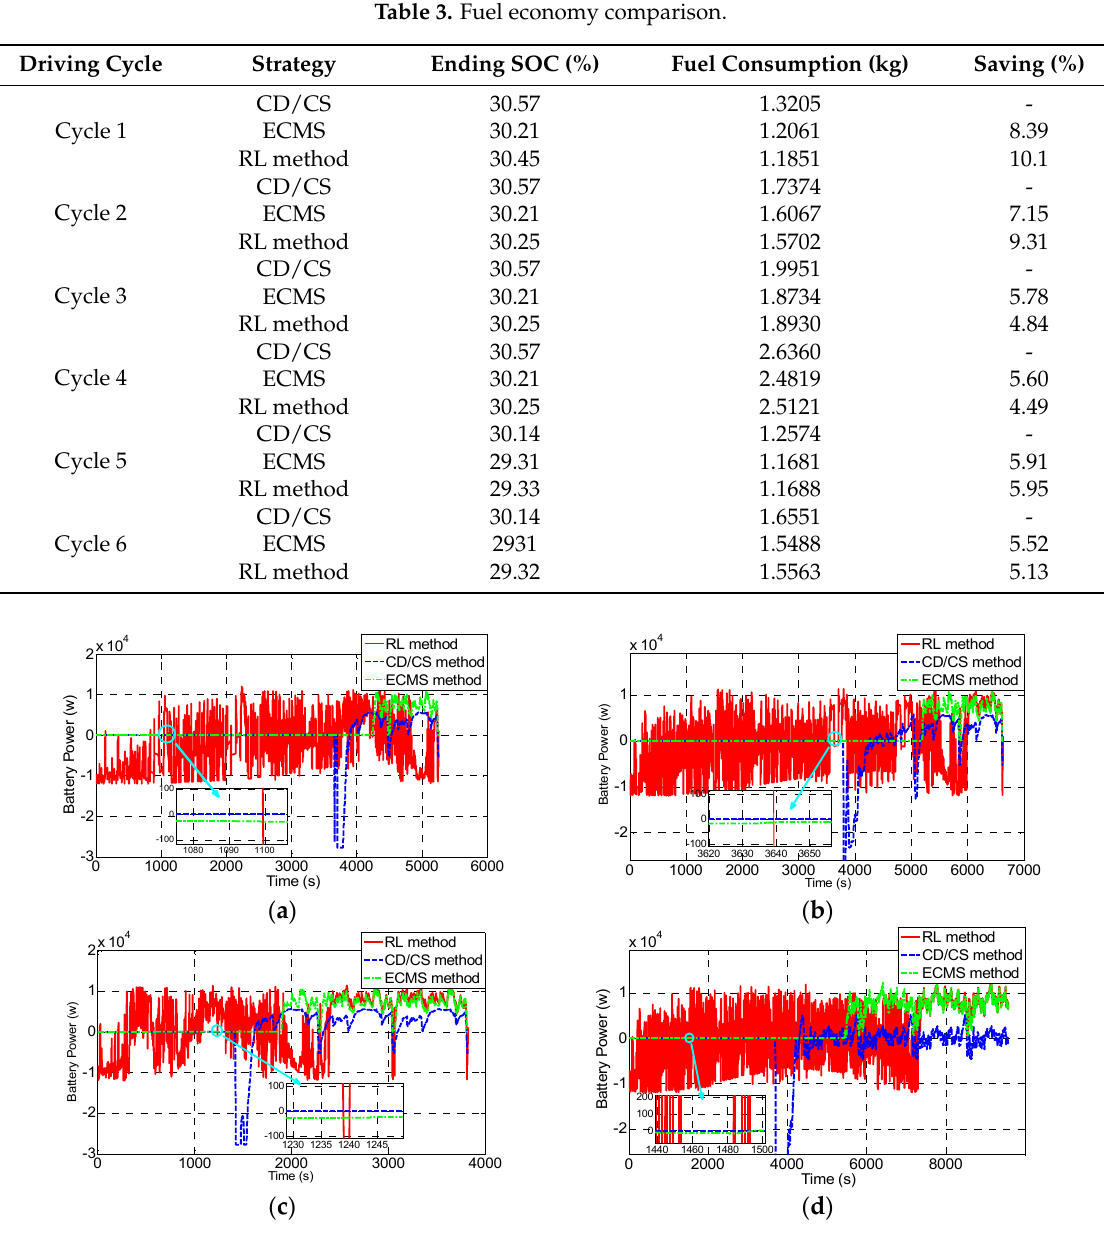
( d ) Figure 11. SOC comparison of driving cycles. ( a ) Cycle 1; ( b ) Cycle 2; ( c ) Cycle 3; and ( d ) Cycle 6.